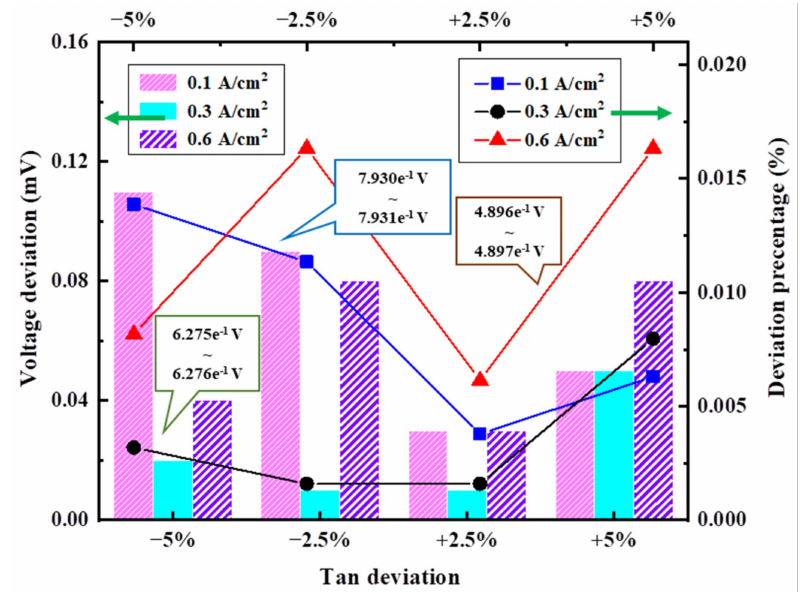
Figure 9. Impacts of AIT deviations on the voltage deviations and their corresponding percentages under three current